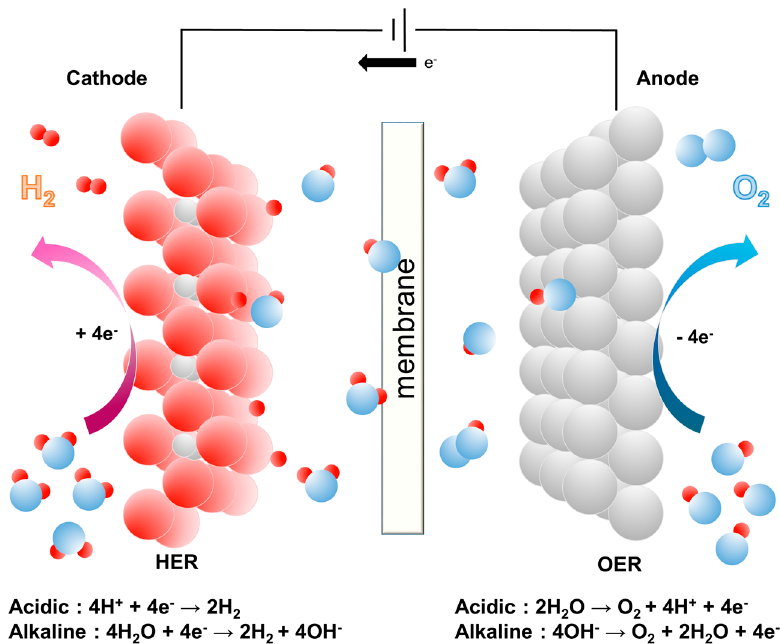
Figure 1. Schematic of the electrochemical water spli tt ing and related reaction kinetics.